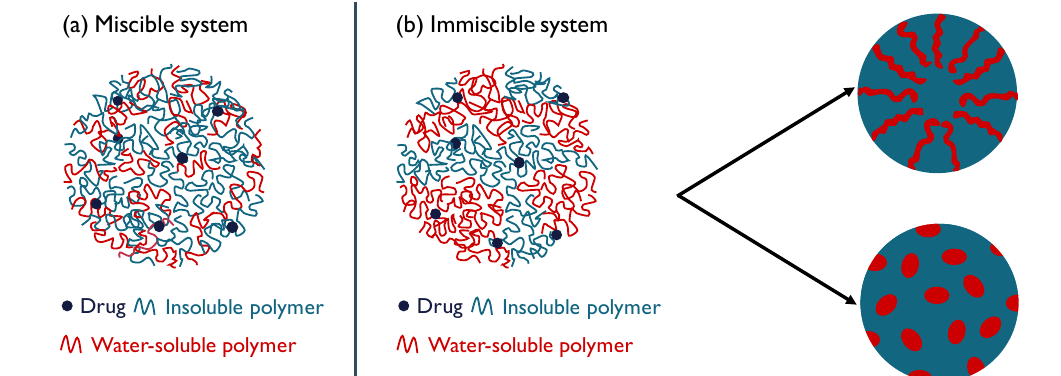
Figure 1. Schematic representation of an amorphous solid dispersion (ASD) particle based on a miscible system ( a ) and an immiscible system ( b ). In the case of an immiscible system, distribution of the water-soluble polymer in the ASD particle will determine what kind of pores that will be formed and hence is expected to influence the drug release from this particle.